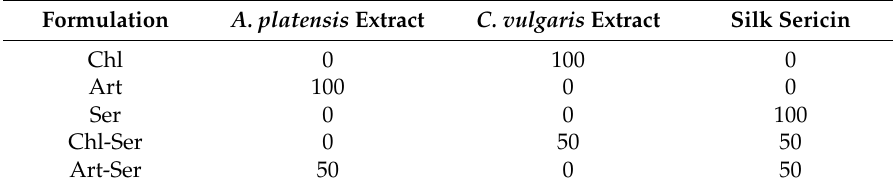
Table 1. Theoretical composition of microspheres reported as % w / w of A. platensis extract, C.